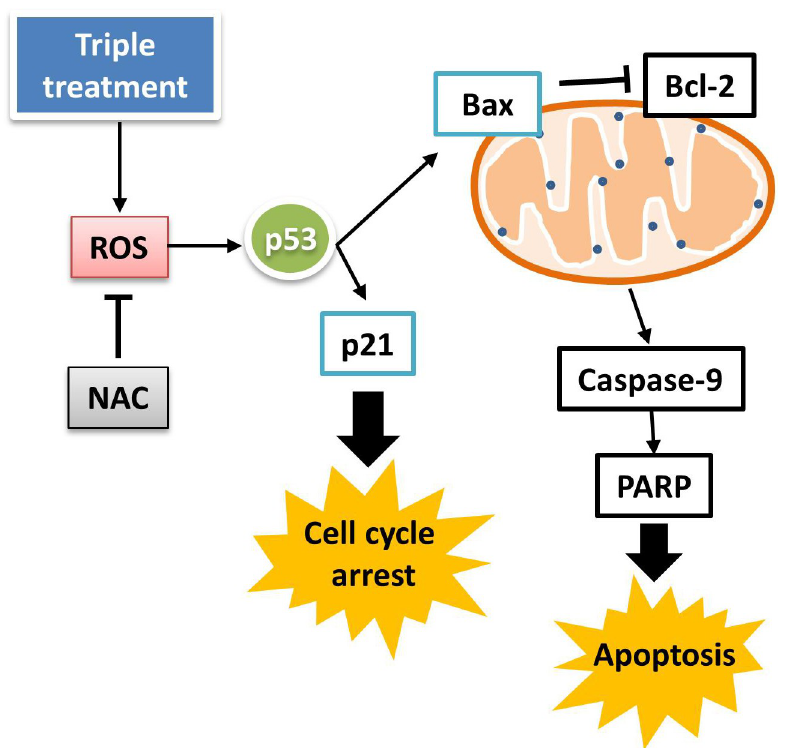
Fig 8. Schematic illustration for molecular mechanism of cytotoxic activity of the triple treatment on PANC-1 cells with CGA, TC-HT, and LIPEF.